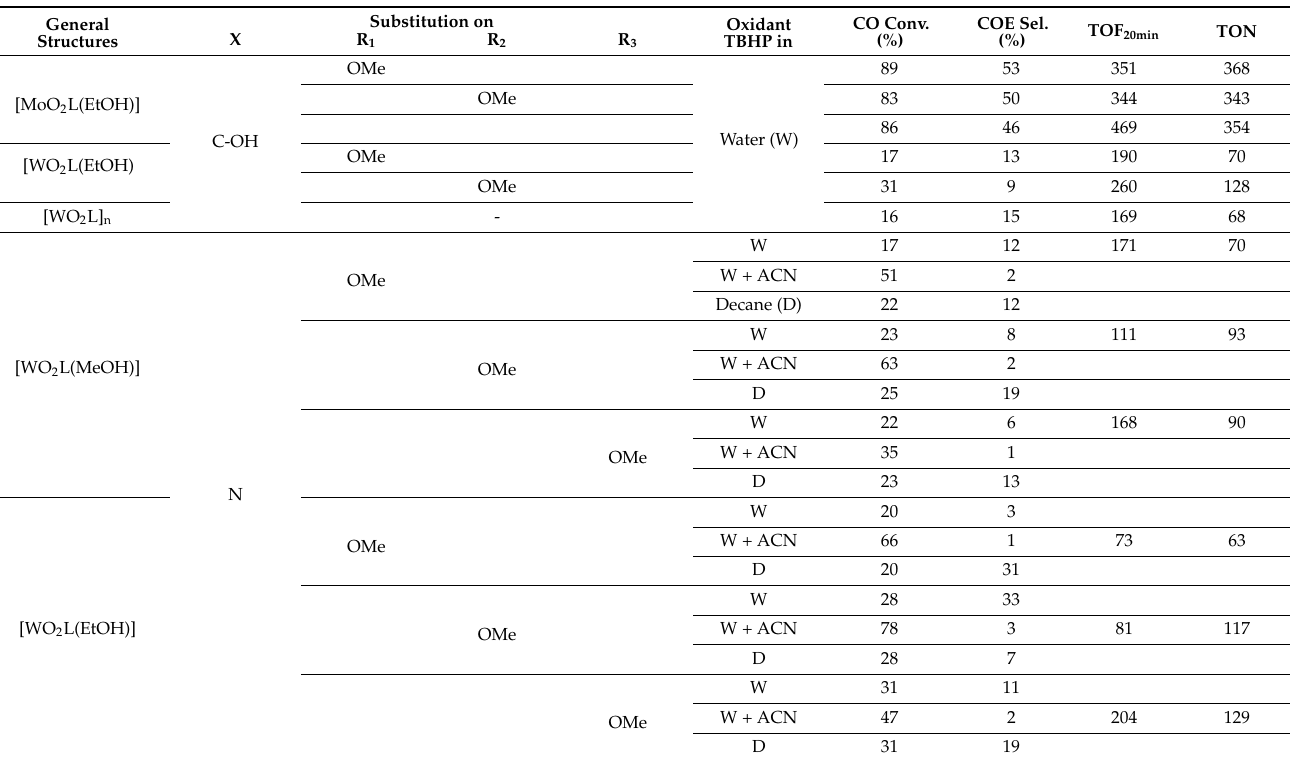
Table 4. Results of CO epoxidation and selectivity toward COE under organic solvent free conditions with MoO 2 L complexes from Figure